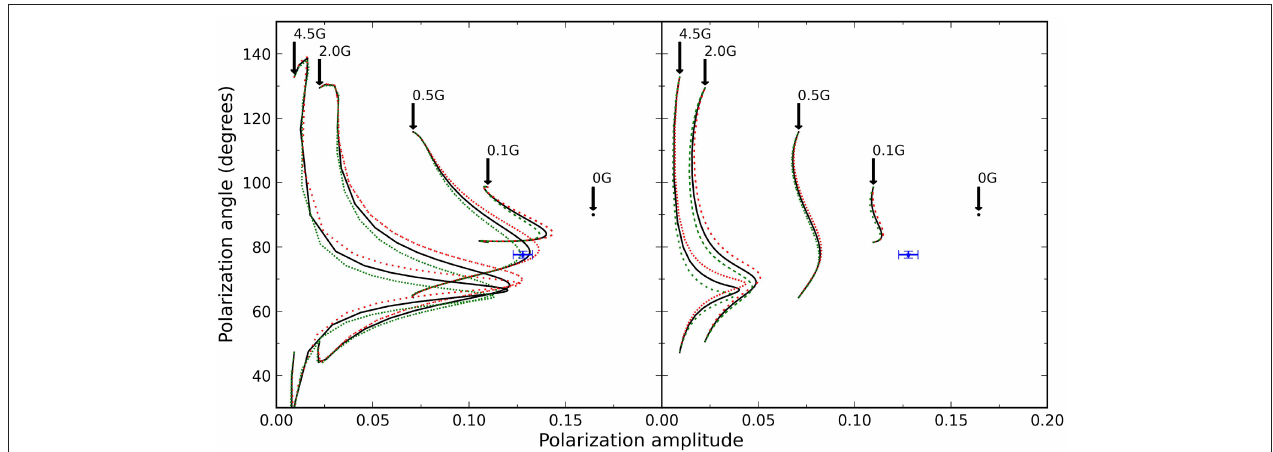
FIGURE 5 | Shown in black are the parallel(left) and perpendicular(right) model grids for Field I as they also appear in Figure 3. The dotted lines represent added (red) and subtracted (green) uncertainties in the SiX1430 polarization angle. Only a few B-isocontours are shown and labeled to avoid overcrowding due to intersecting contour lines. The measured HeI1083 polarization parameters are shown with corresponding measurement uncertainties. Propagating the SiX1430 uncertainty requires new grids to be computed since the shapes of the grid changes as seen by the bending and crossing of model contours.